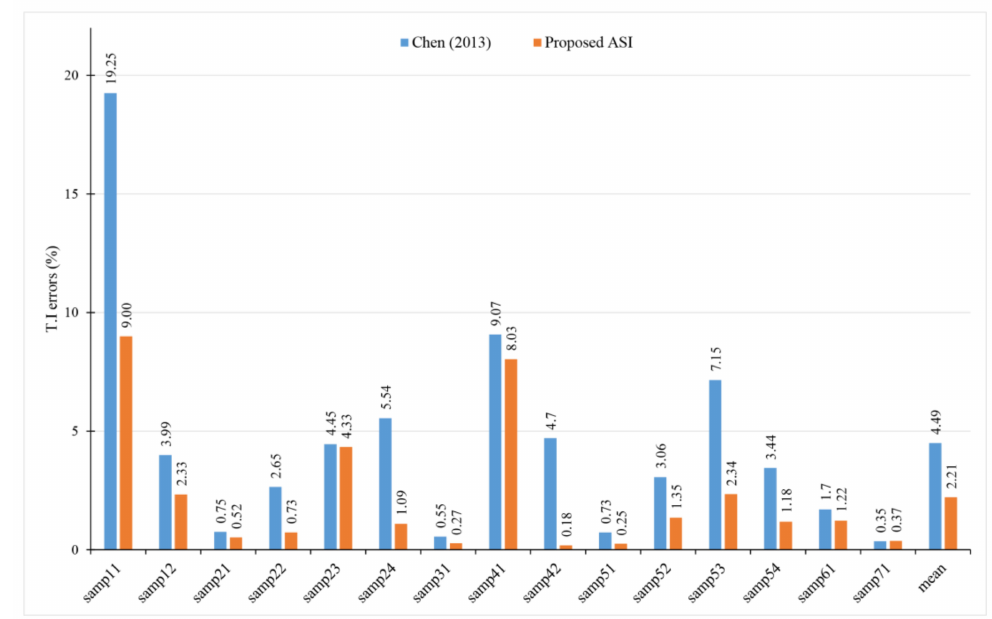
Figure 8. Comparison between the T.I errors (%) obtained for each sample by Chen’s MHC method and the proposed ASI